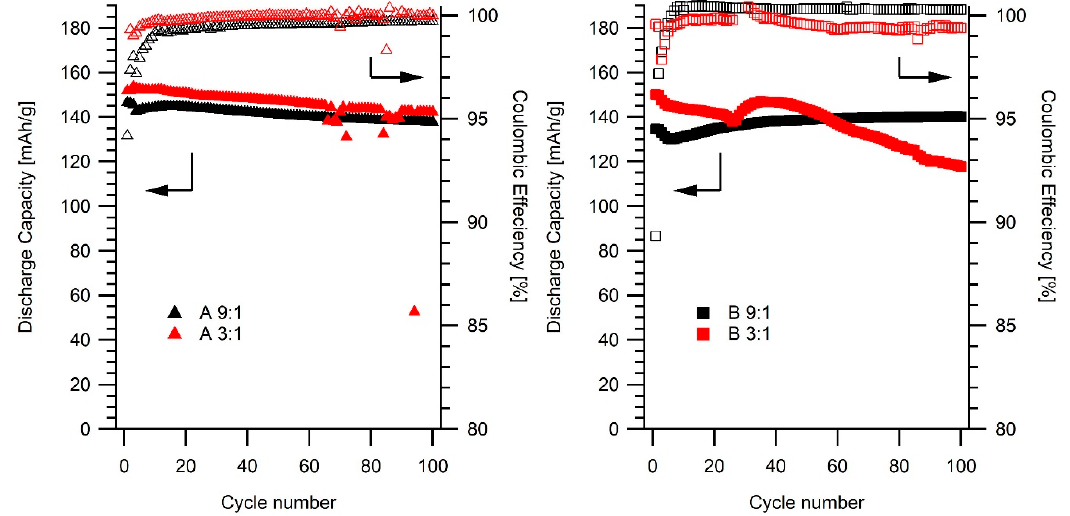
Figure 8. Cycling performance for Li||LFP cells for 100 cycles at 0.5 C and 80 °C.